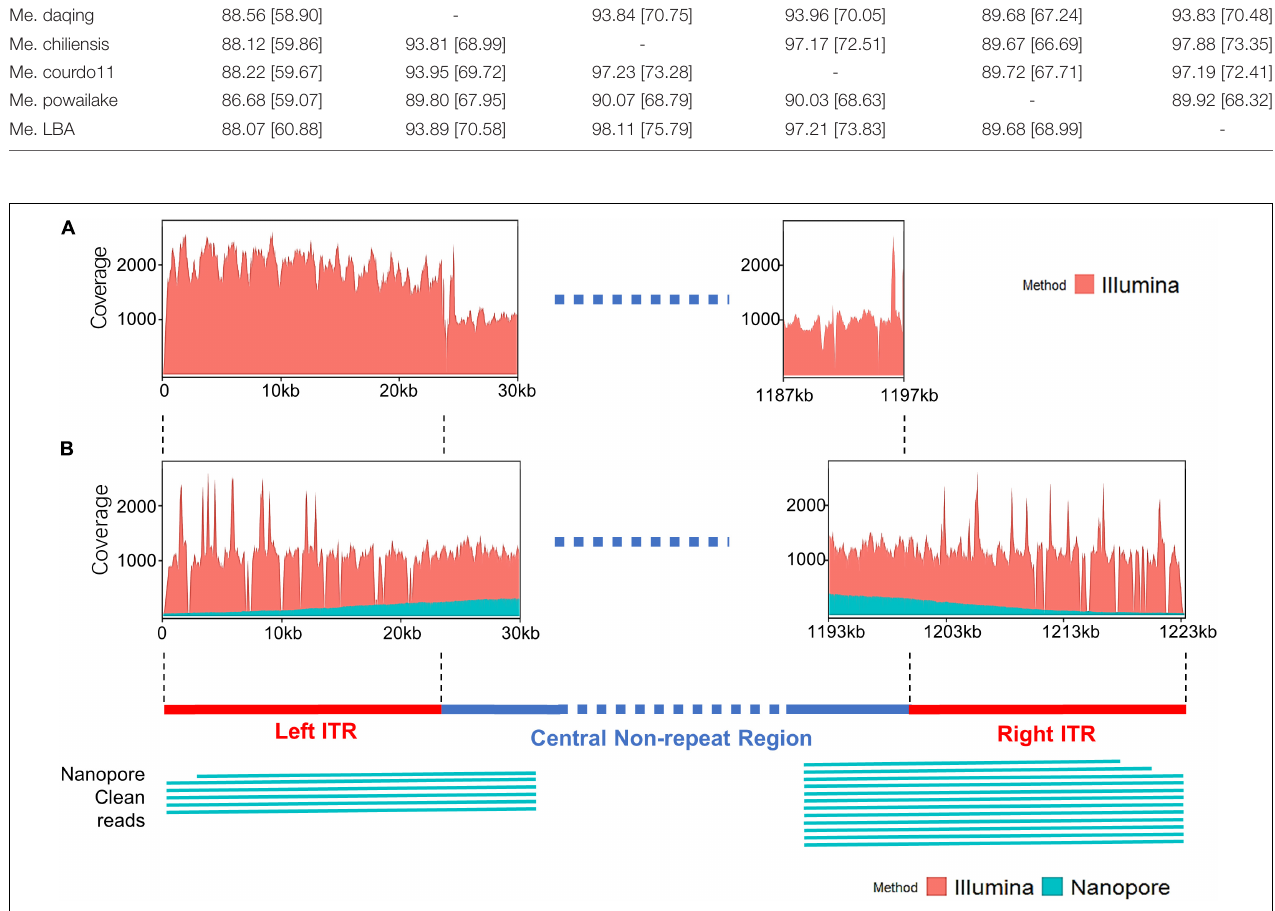
FIGURE 4 | (A) The coverage plots of Me. baoshan draft genome by mapping Illumina reads against the draft map genome. (B) The coverage plots of Me. baoshan complete genome by mapping Illumina and Nanopore reads against the complete genome map, followed by schematic representation of Nanopore long reads ( > 26 kb) that mapped against the terminal regions of the complete map.